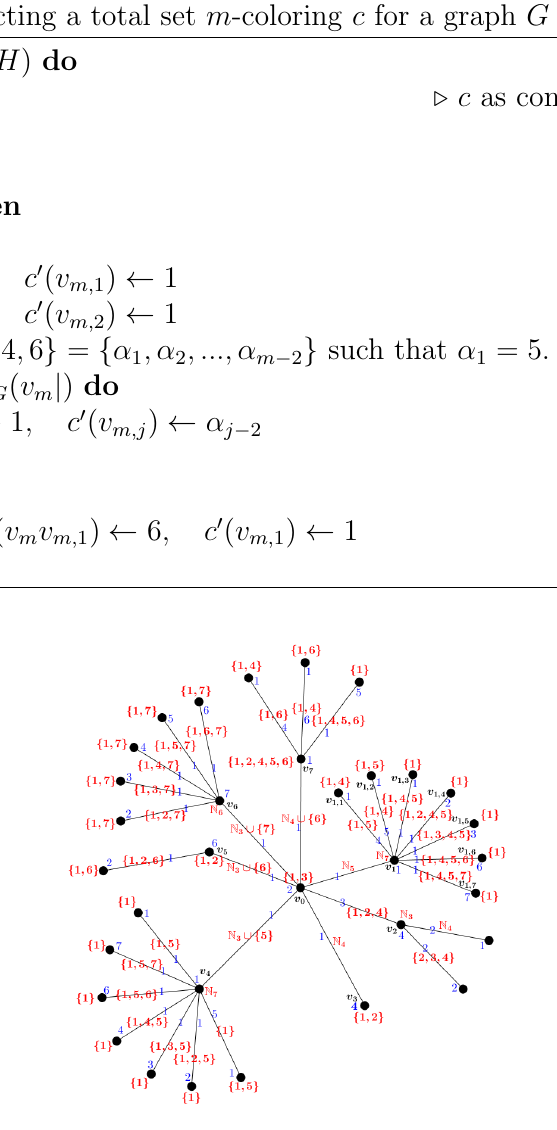
Figure 2: A tree of height 2 with a total set 7-coloring generated by Algorithm 2